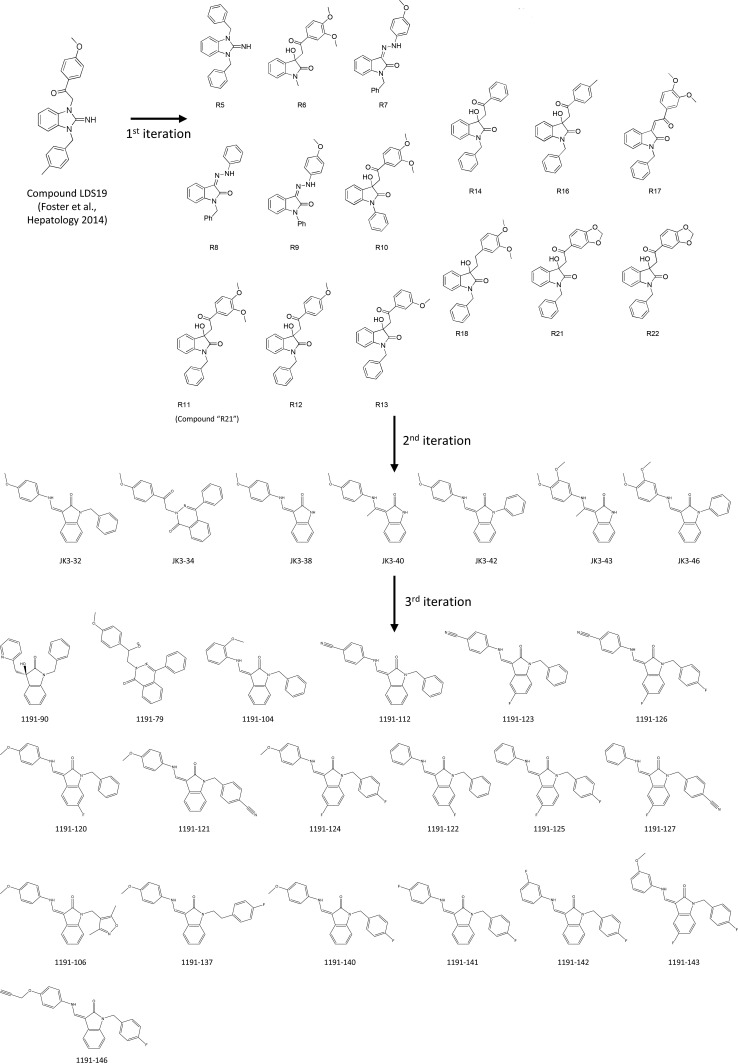
Evolution of LDS19 compound series including JK3/32.LDS19 was identified from an in silico screen using a 3ZD0-based channel structure model and demonstrated to have potent anti-p7 activity in vitro and in cell culture, as described previously (Foster et al., 2011). Three subsequent iterations of compound structure variations were undertaken to establish a comprehensive SAR and JK3/32 was established as the series lead. Compound RS11 (aka R21) was used as a negative control in cell entry assays due to a lack of activity versus genotype 1b and 3a HCV.